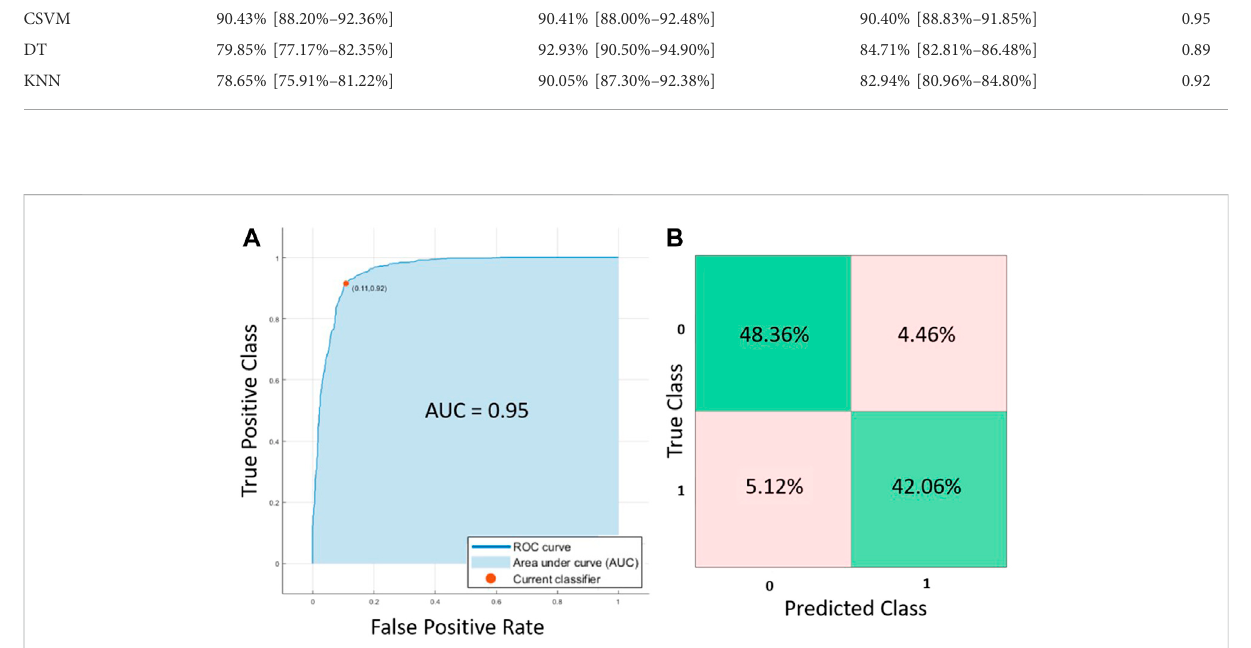
FIGURE 4 (A) ROC curves and (B) confusion matrix for the Cubic SVM trained